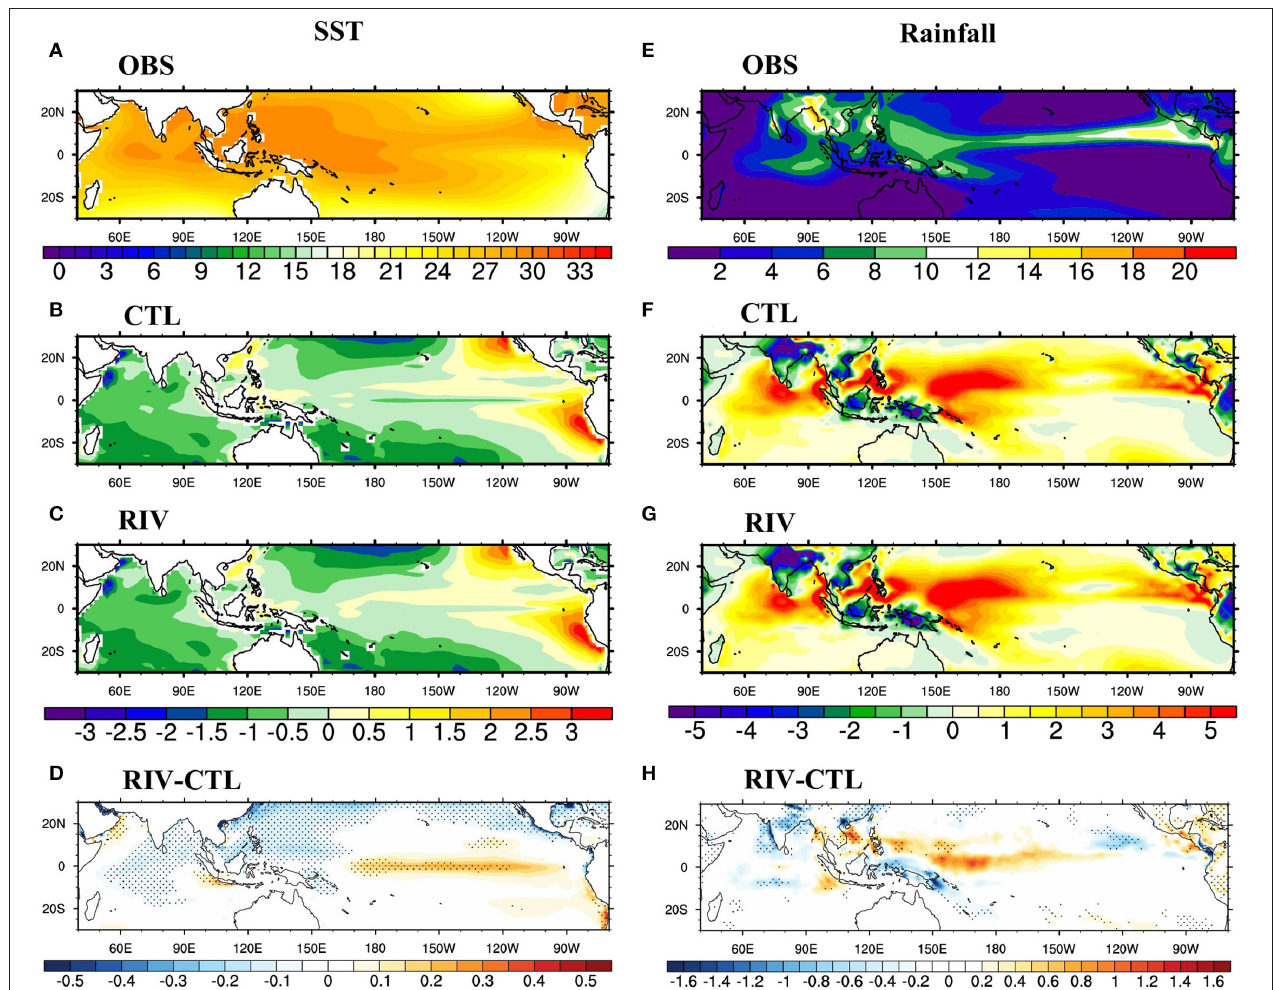
FIGURE 10 | June-September (JJAS) mean SST ( ◦ C) in (A) observations (ERSST), and JJAS mean biases in model-simulated SST ( ◦ C) for (B) CTL run, (C) RIV run, and (D) RIV-CTL. (E–H) Same as (A–D) but for rainfall (mm day − 1 , observational rainfall from GPCP). Differences significant at 90% confidence level are stippled in (D,H) . Biases are calculated for the period 1981–2017.